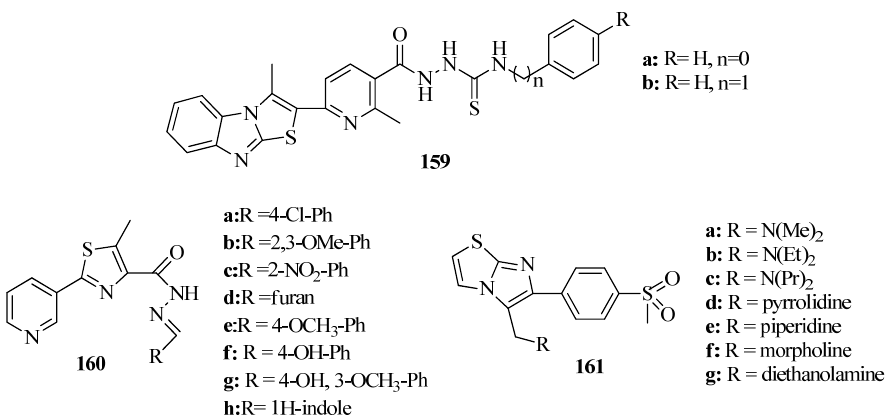
Figure 62. Structures of benzimidazothiazole, thiazole-based hydrazid and 4-(methylsulfonyl)phenyl)imidazo[2,1-b]thiazole derivatives.